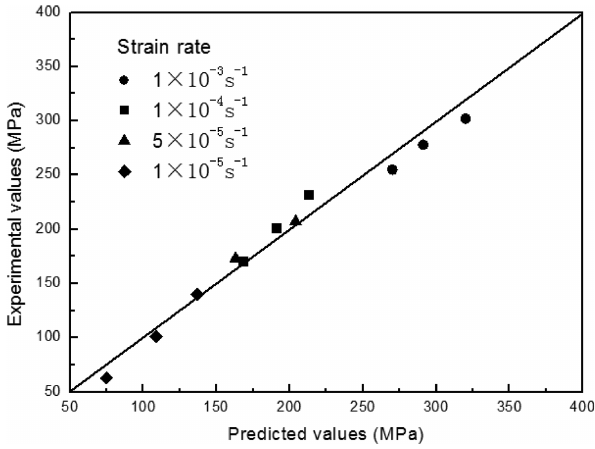
Figure 9: Comparison of the predicted values and the experimental values of σ ε = 0.1% at different strain